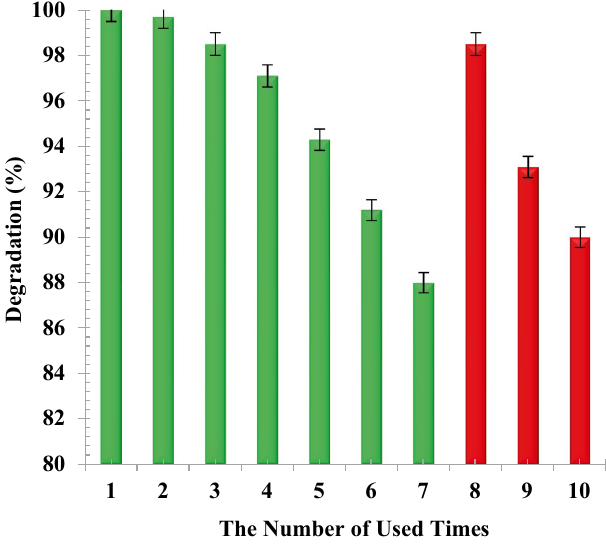
Figure 13. Reusability and regeneration of ZrO 2 /TiO 2 /Fe 3 O 4 photocatalyst for naproxen